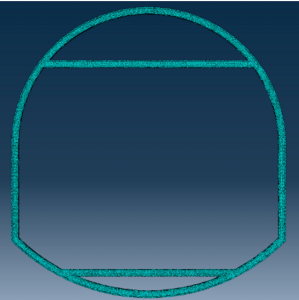
Figure 21. The structure of the improved steel set.